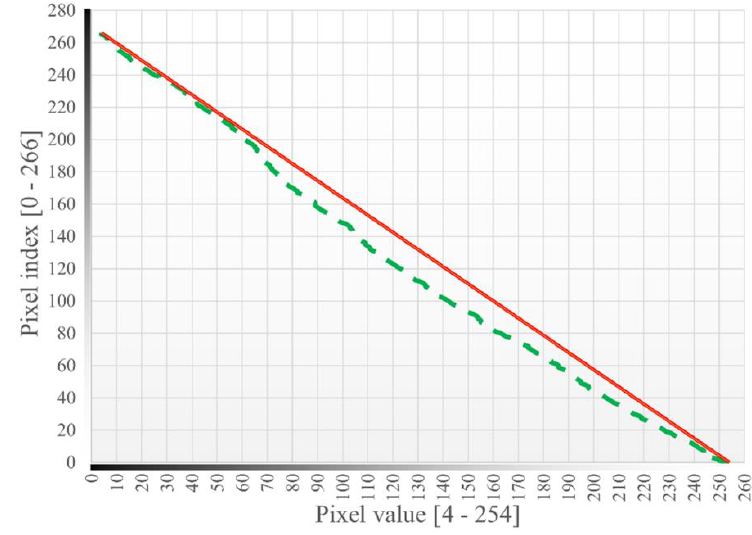
Figure 10. Pixel value as a function of position on the temperature scale. The dashed green line depicts the pixel values extracted from the image. The solid red line displays the behavior of the equation obtained by linear regression.